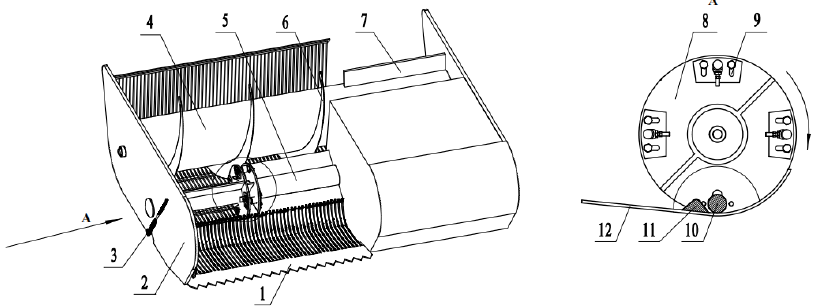
Figure 2. Diagram of conveying and soil-removing device: (1) fixed digging shovel; (2) frame; (3) return spring; (4) spiral shaft; (5) feed scraper; (6) spiral blade; (7) discharge scraper; (8) vibration plate; (9) regulating port; (10) vibration exciter; (11) vibratory element; (12) bar screen.